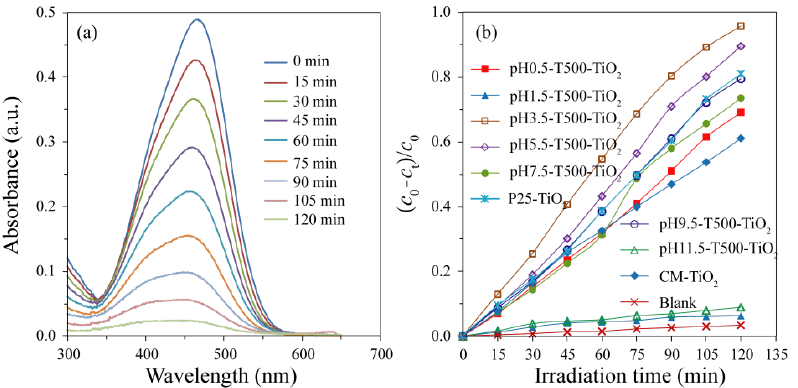
Figure 8. ( a ) Spectral changes of the centrifuged methyl orange solution with pH3.5 − T500 − TiO 2 sample as the photocatalyst and ( b ) Variation of degradation percentage of methyl orange with Table 1. Properties and activity parameters of the prepared and commercial TiO 2 samples.